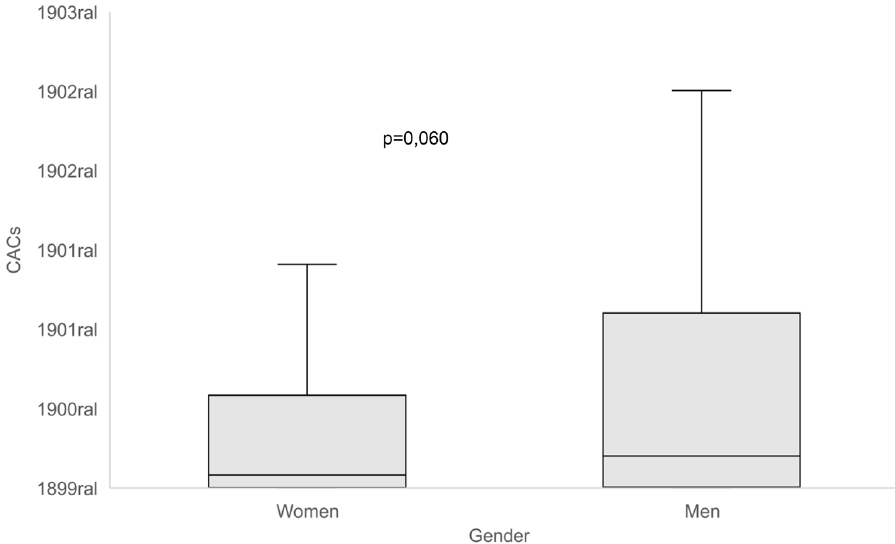
Figure 2. Coronary calcium content between the sexes. CACs values are expressed in a logarithmic display and sex comparisons made by Mann–Whitney test.